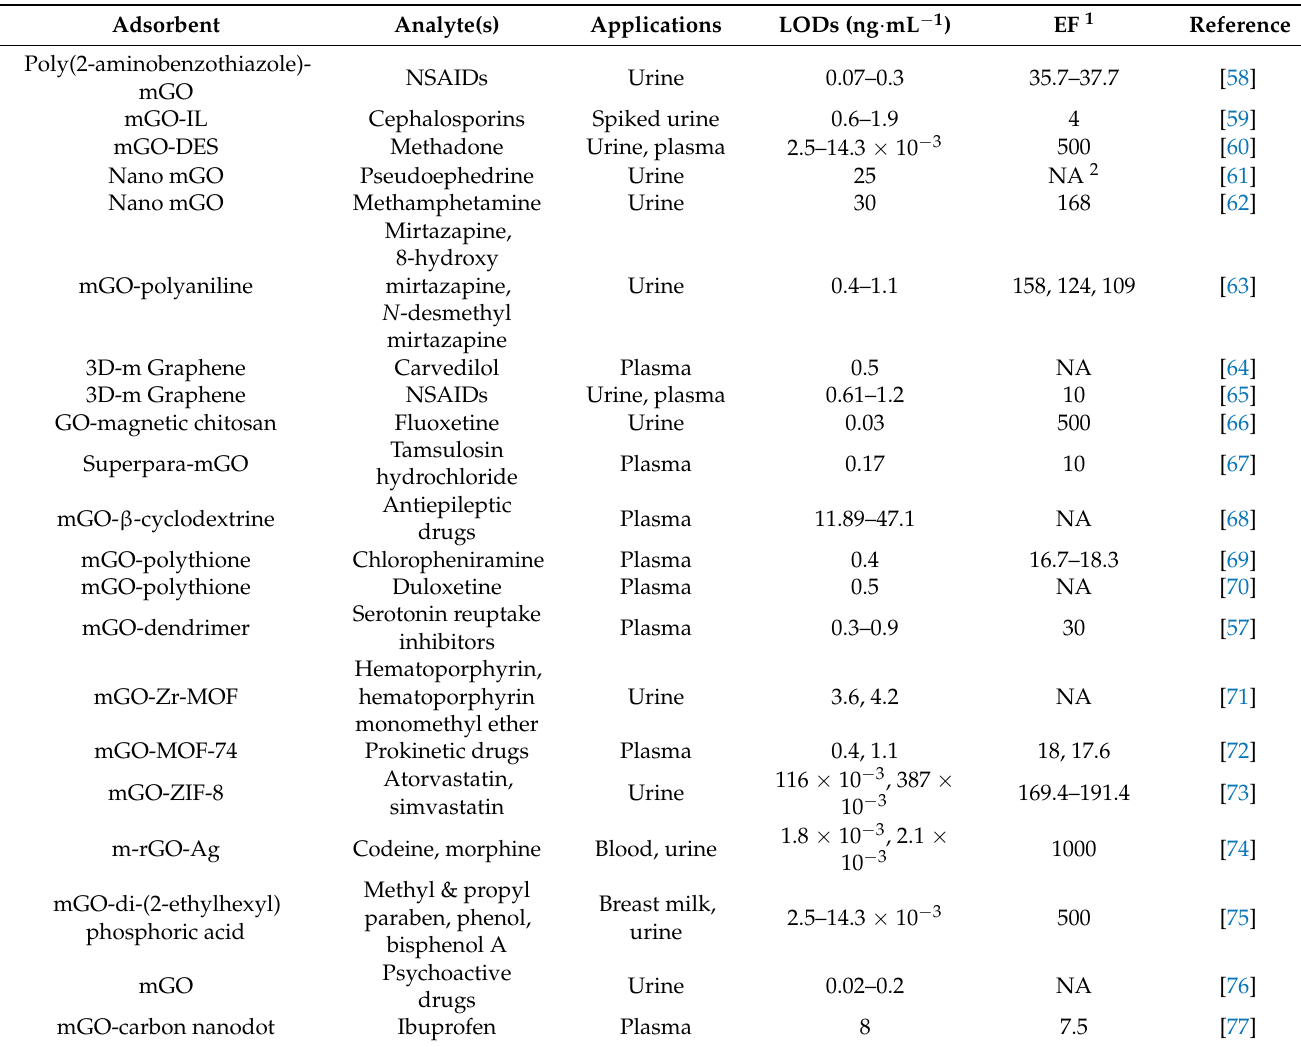
Table 1. Recent applications of graphene-based nanomaterials in